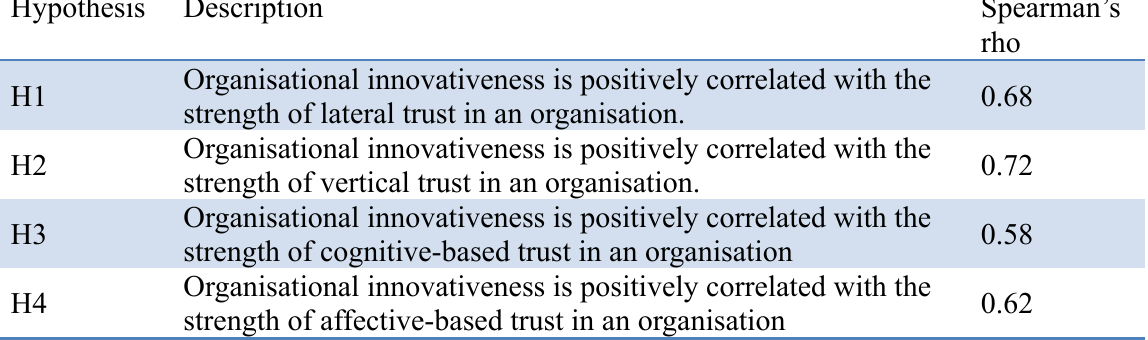
Table 1: Research hypotheses and corresponding Spearman’s rho values